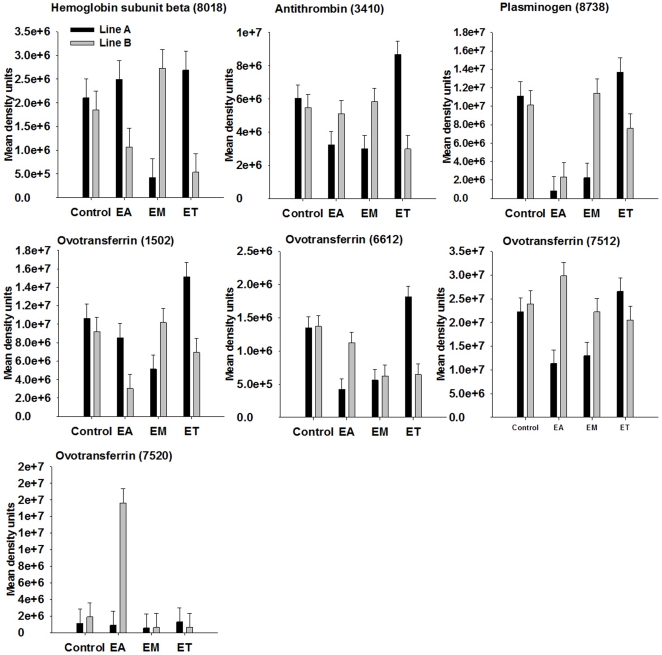
Broiler genetic line×coccidia infection interactions (P<0.001) for iron-binding and blood-clotting proteins.Line A and B broiler chicks were either not infected (control) or were inoculated with 1 of 3 Eimeria species, E. acervulina (EA), E. maxima (EM) or E. tenella (ET) at 15 d post-hatch. At 21 d (6 d post-infection) serum was harvested from whole blood samples and used for 2D gel electrophoresis followed by MALDI TOF/TOF. Protein density was evaluated by densitometric analysis of spot intensity followed by ANOVA. Values represent mean density units ± SEM (N = 6).